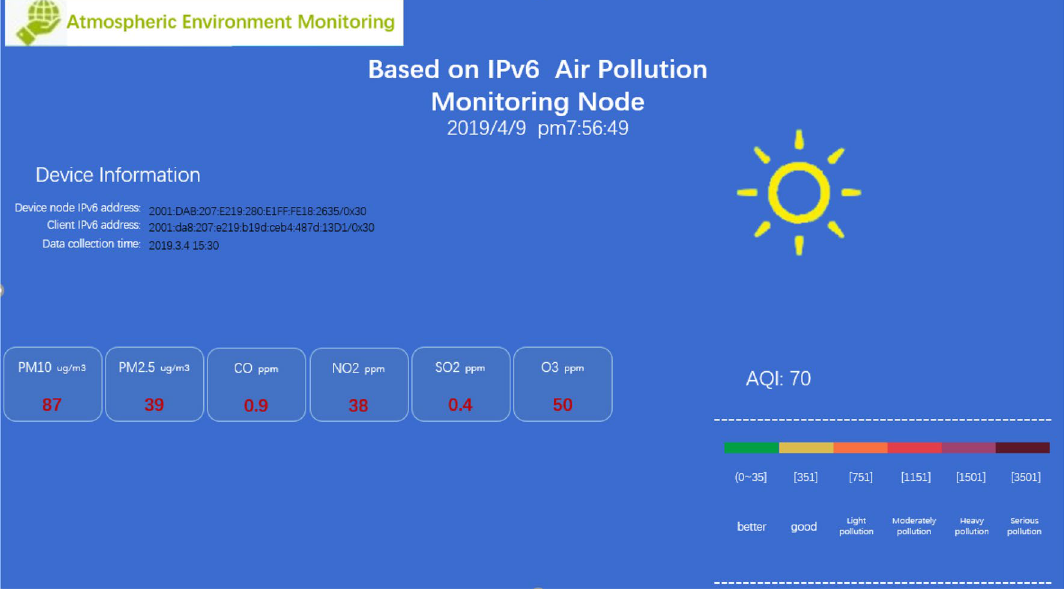
Figure 12. Embedded web